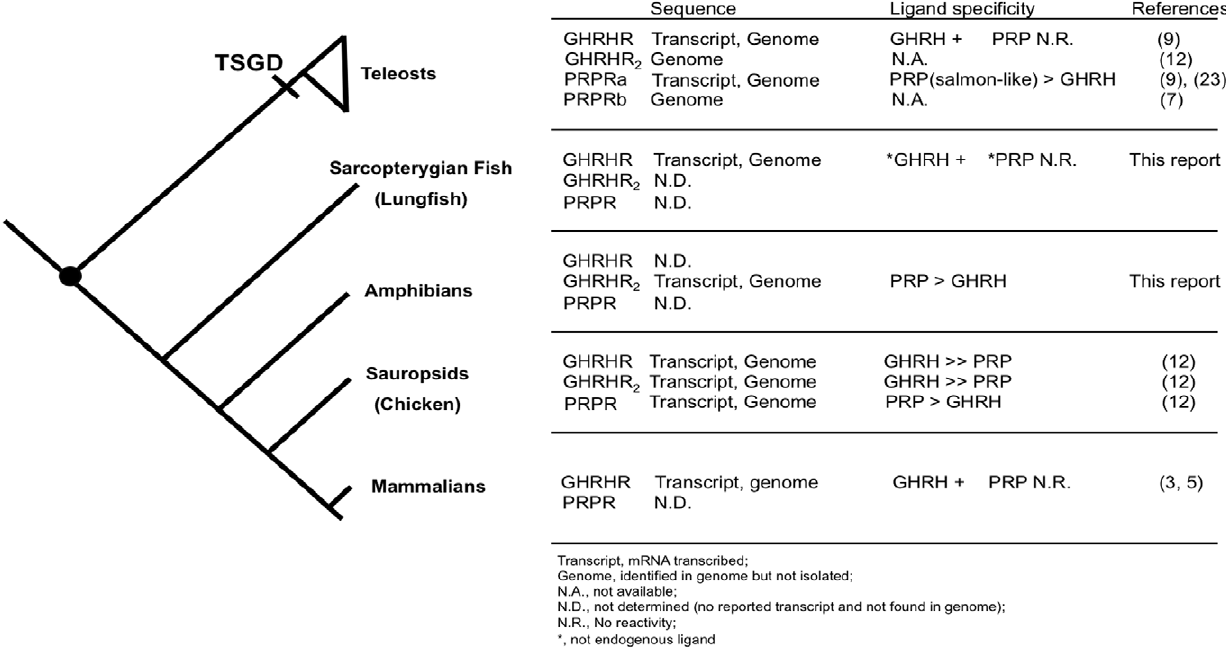
N Figure 5. GHRHR, GHRHR2 and PRPR in Osteichthyes lineage. Identified GHRHR, GHRHR2, PRPR and their ligand specificity were summarized ) and the timing of TSGD (Teleost-specific genome in each taxon group. The Sarcopterygii-Actinopterygii split was marked by a black dot ( duplication) was indicated [14]. Abbreviations and terminology: Transcript refers to mRNA transcribed; Genome means identified in genome but not isolated; N.A., not available; N.D., not determined (no reported transcript and not found in genome); N.R., No reactivity; *, not endogenous